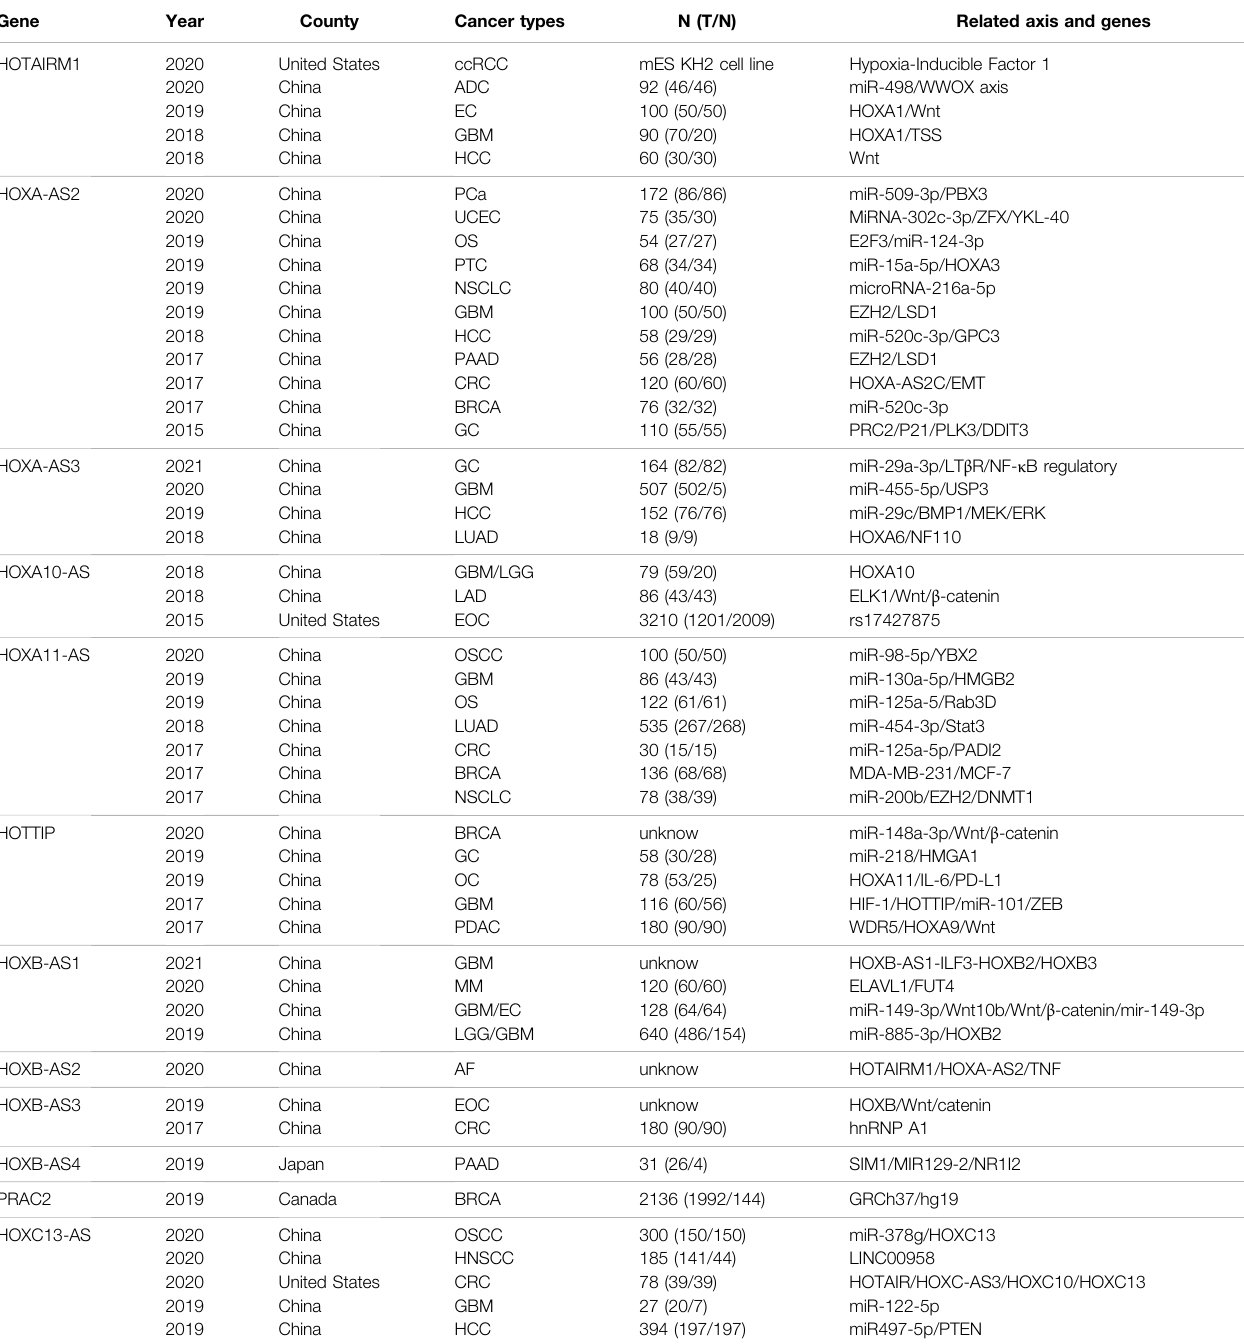
TABLE 1 | A brief review of the literature. The related interactive genes of HOXATs and involvement in functional role in different cancers. N (T/N):number (tumor/normal). ADC: Lung adenocarcinoma; AF: Atrial fi brillation; BRCA: Breast invasive carcinoma; COAD: Colon adenocarcinoma; CRC: colorectal carcinoma; EC: